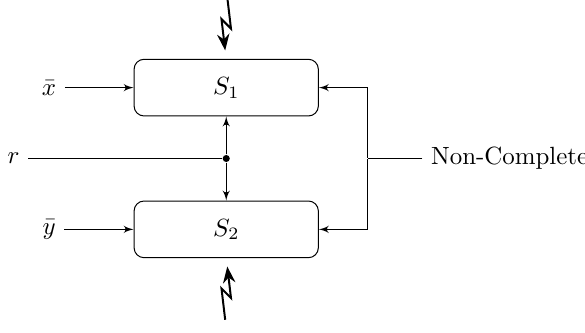
Figure 3: Two masked S-boxes sharing the same randomness. Probes are indicated by lightning signs. Since both S-boxes are non-complete without the randomness r , the probes do not return secret